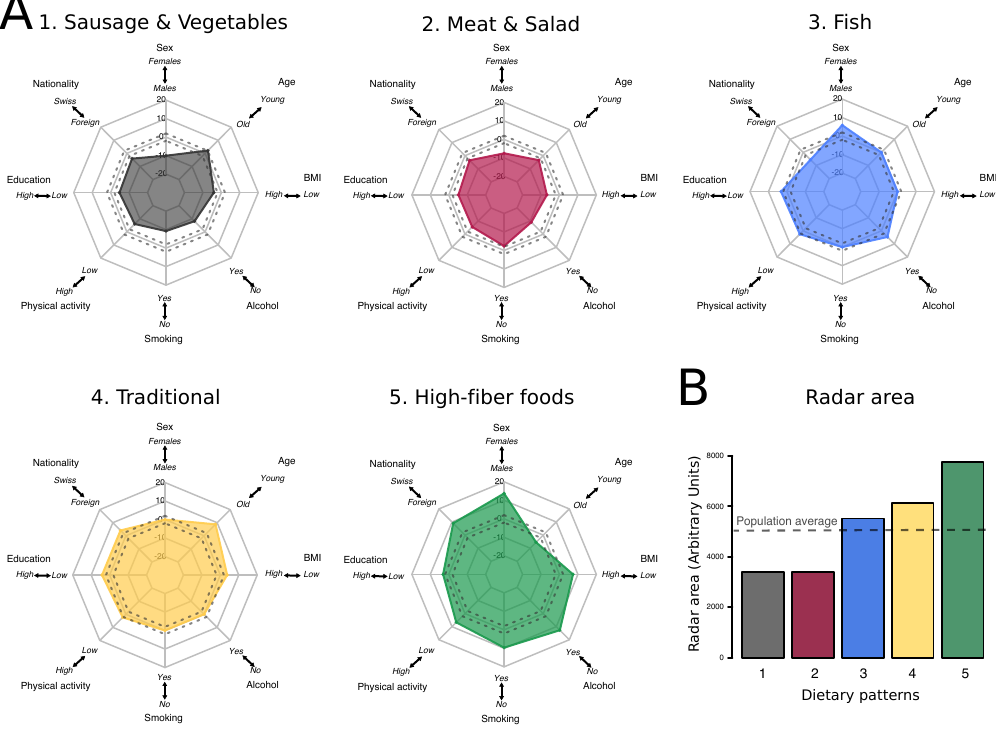
Figure 2. Association between dietary patterns and demographics and lifestyle behaviors ( N = 15,936). ( A ) v-test statistics between individuals assigned to a dietary pattern and the overall population for the eight covariates included in the study. v-test indicates whether categories of participants are significantly over- (v-test > 1.96) or underrepresented (v-test < –1.96) in a dietary pattern compared to the overall study population. Grey dashed lines indicate the non-significant range ( − 1.96; 1.96). For representation purposes, the six categorical covariates were dichotomized (BMI: “low” < 25 kg/m 2 vs. “high” ≥ 25 kg/m 2 ; Alcohol: “no” vs. “yes” moderate or high consumption; Smoking: “no” never vs. “yes” former, light or heavy smoker; Physical activity: “low” ≤ once a week vs. “high” ≥ twice a week; Education: “low” mandatory education vs. “high” upper secondary and tertiary education; Nationality: “Swiss” vs “Foreign”); ( B ) Areas of the radar plots shown in A (arbitrary units). Horizontal dashed line indicates the radar area of the total study population (all v-tests =